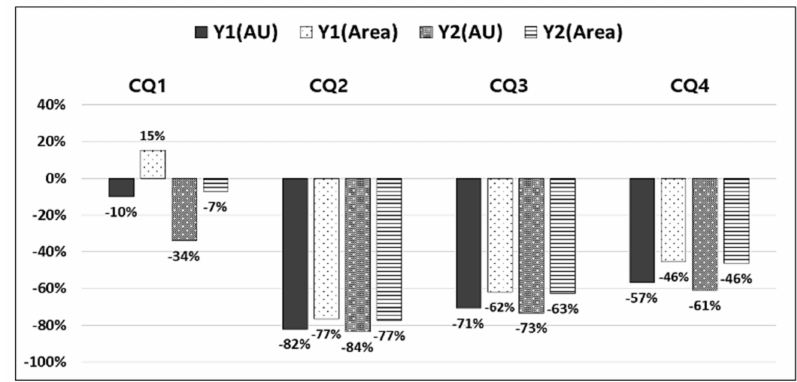
Figure 11. Reduction rate of the standard deviation of other experimental results compared to reproducibility